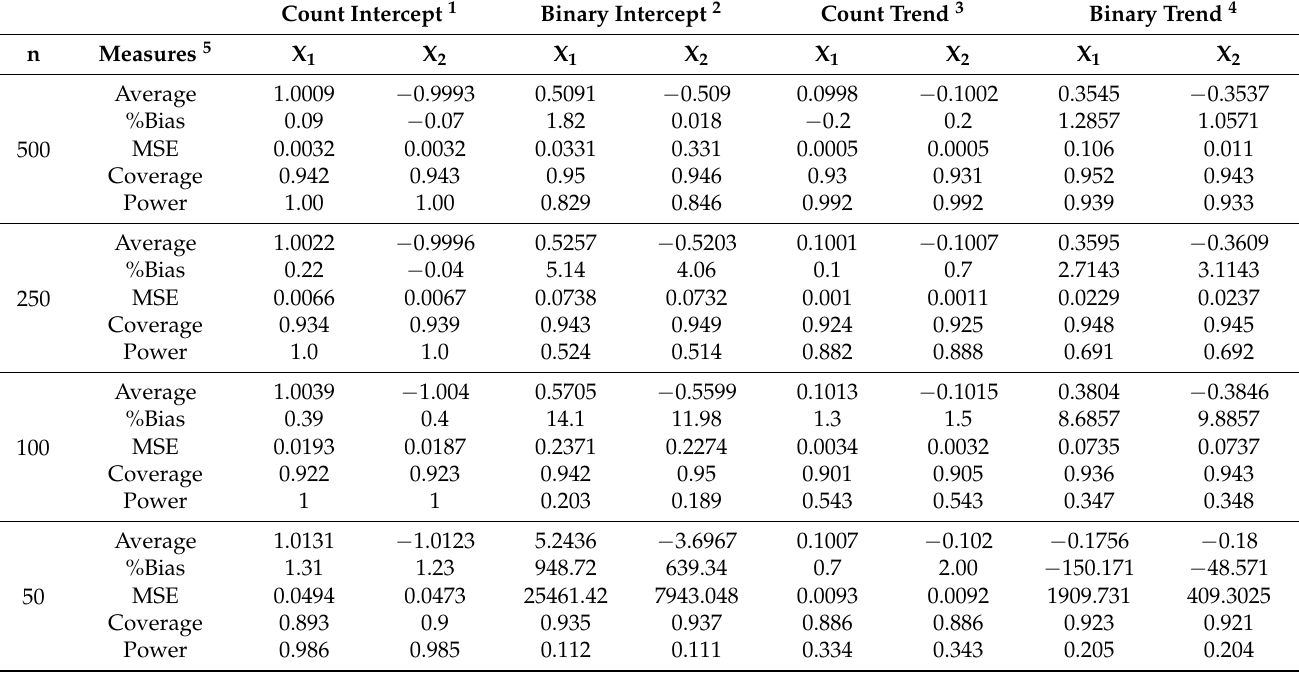
Table 2. Monte Carlo results of